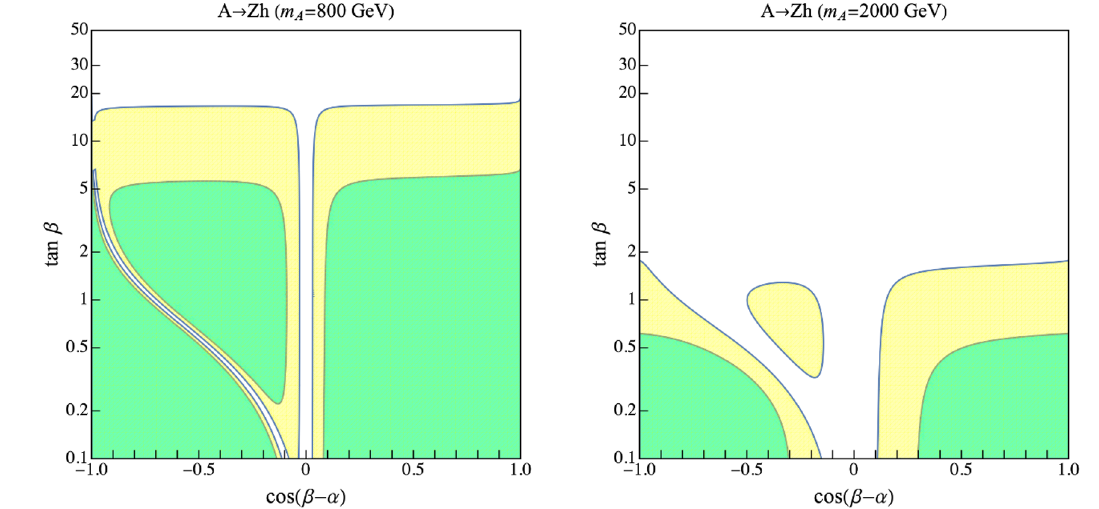
Figure 3 . Excluded regions at 95% C.L. in the cos( (cid:12) searches for the CP-odd heavy Higgs boson via the A panel) and m A = 2000 GeV (right panel). The shaded regions are excluded under the current LHC 13 TeV 36 : 1 fb (cid:0) 1 (green) and the future projected HL-LHC 14 TeV 3000 fb (cid:0) 1 (yellow), respectively.